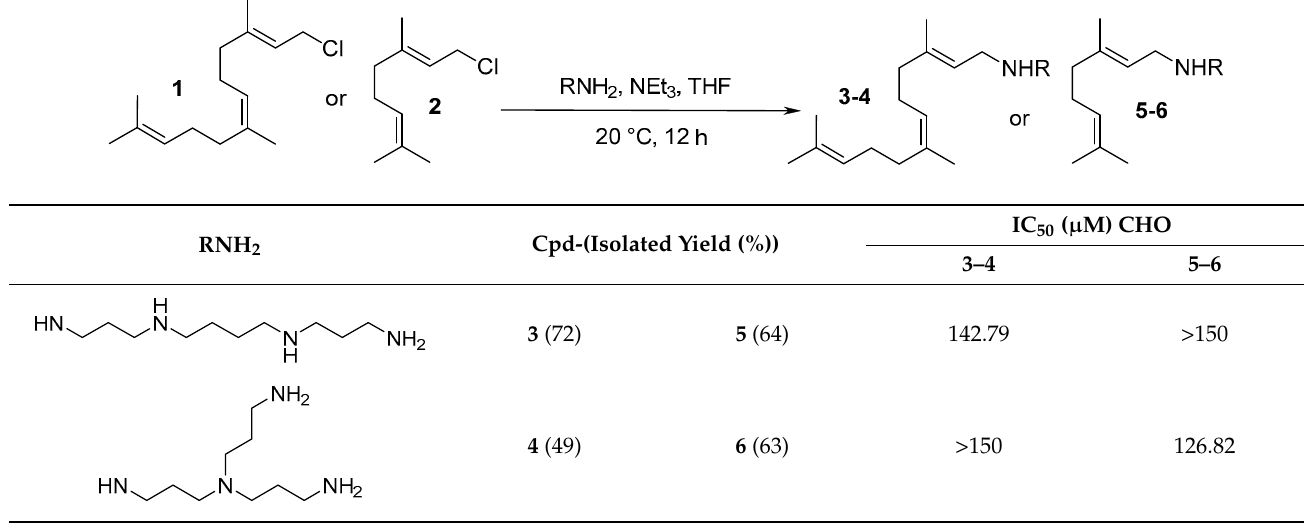
Table 1. Polyaminoisoprenyl derivatives 3 – 6 synthesis from farnesyl or geranyl chloride 1 – 2 .